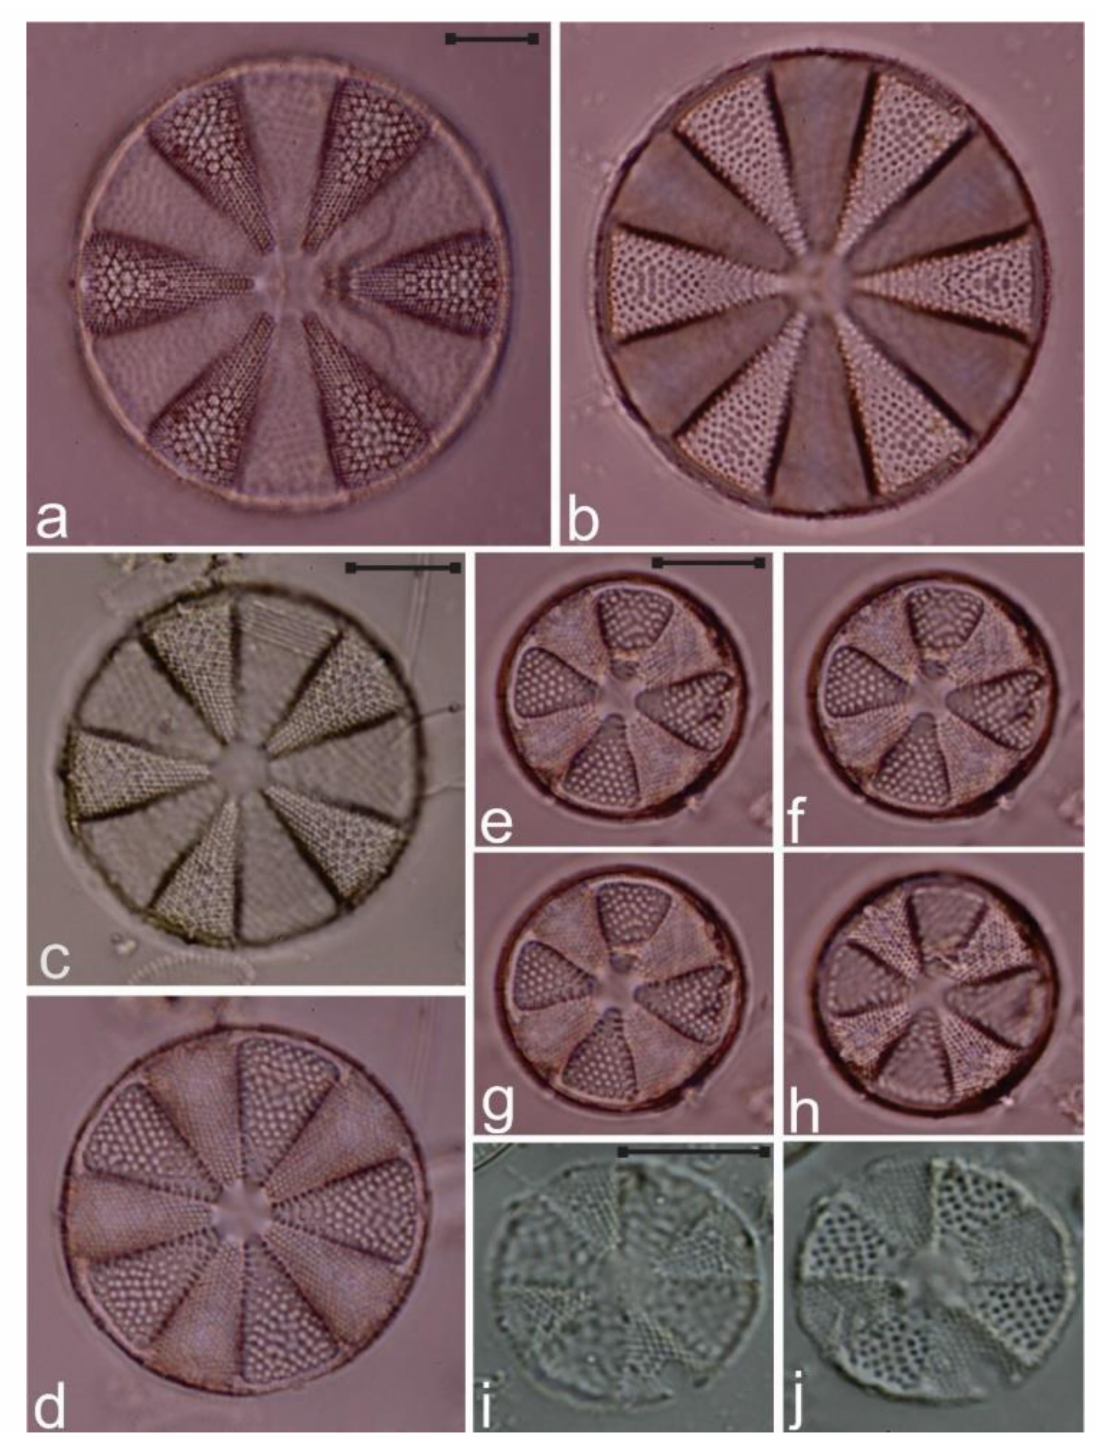
Figure 3. ( a – d ) Actinoptychus vulgaris in di ff erent focal planes; ( e – j ) A. minutus . Scale bar = 10 µ